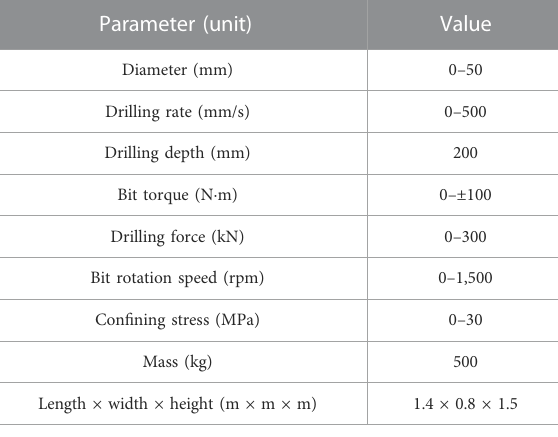
FIGURE 4 Diagram of static elastic energy and con fi ning stress.